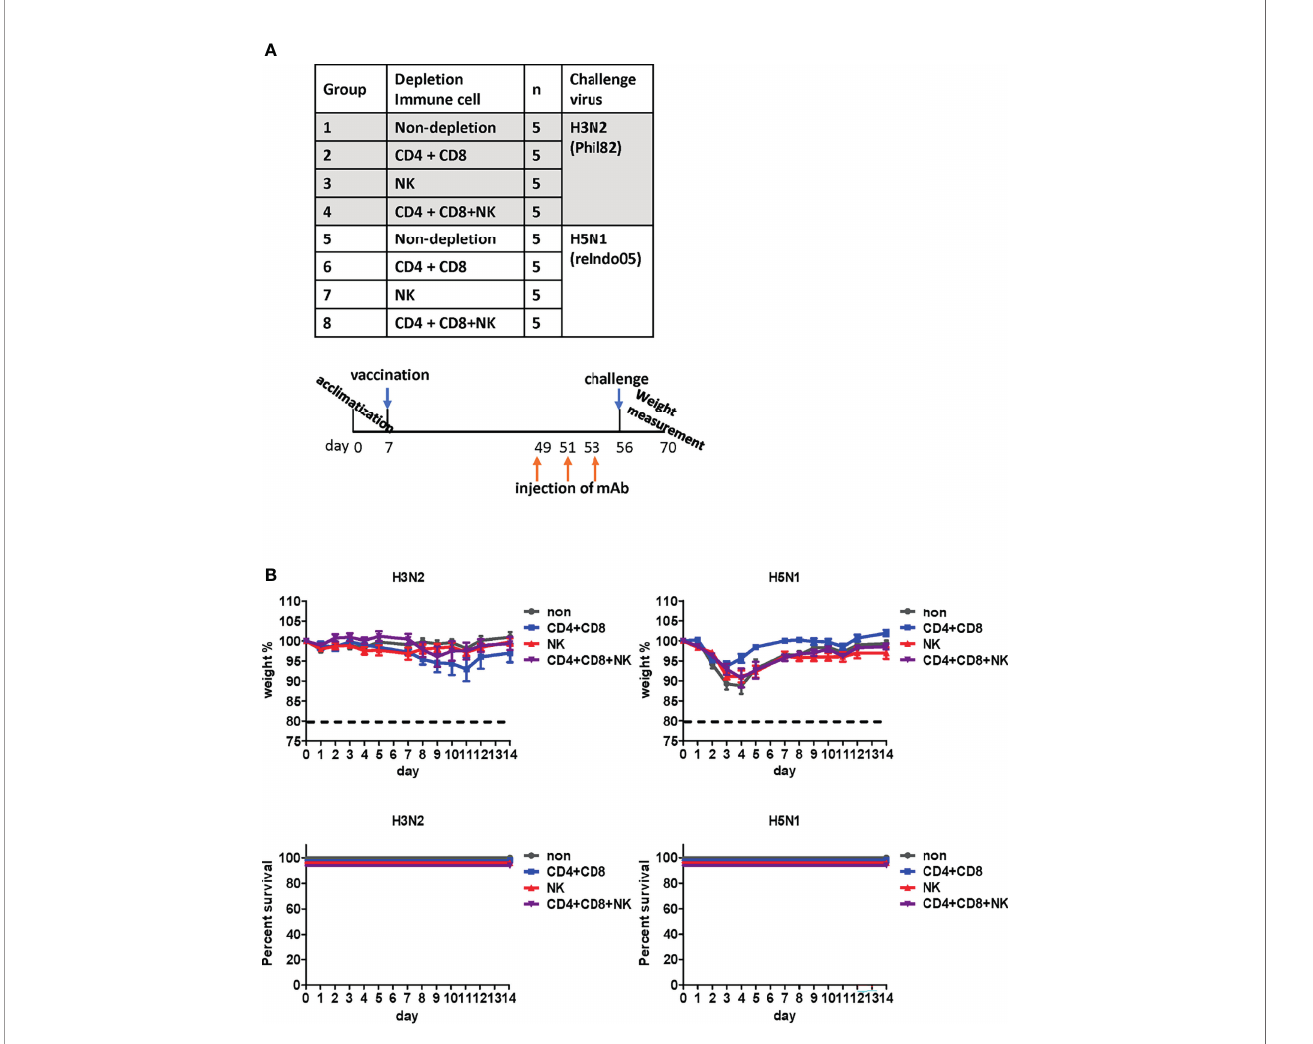
FIGURE 8 | Effect of immune cells against cross-protection in mice. (A) Schematic diagram of the schedule of immune cell depletion in mice. To deplete CD4+, CD8+ T cells, and natural killer (NK) cells, mice were injected with corresponding monoclonal antibodies three times on days 1, 3, and 5 before challenge. Immune cell-depleted mice were challenged with H3N2 of group 2 and H5N1 of group 1 viruses. (B) Contribution of immune cells towards cross-protection. CD4+, CD8+ T cells, and NK cells were depleted in mice. The body weight of mice was measured daily, and changes in the body weight and survival rate are shown. The humane endpoint is a weight-loss reduction of more than 20%, which is indicated by a dotted line in the graph. The graph shows the mean of each cohort (N=5) , and the error bar indicates the standard deviation